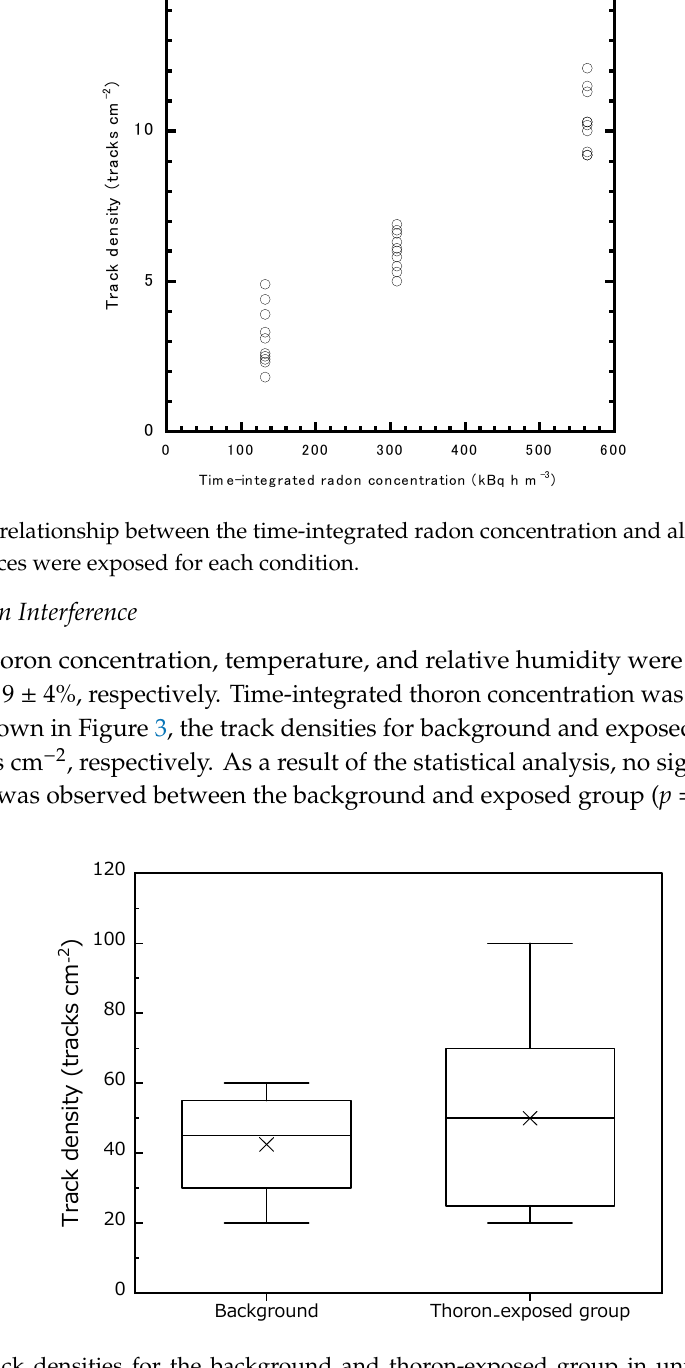
Figure 3. Track densities for the background and thoron-exposed group in unit of tracks cm − 2 . Bottom and top whiskers are the 25th and 75th percentiles, respectively. The lines across the boxes and the cross marks represent the median and the arithmetic mean value,